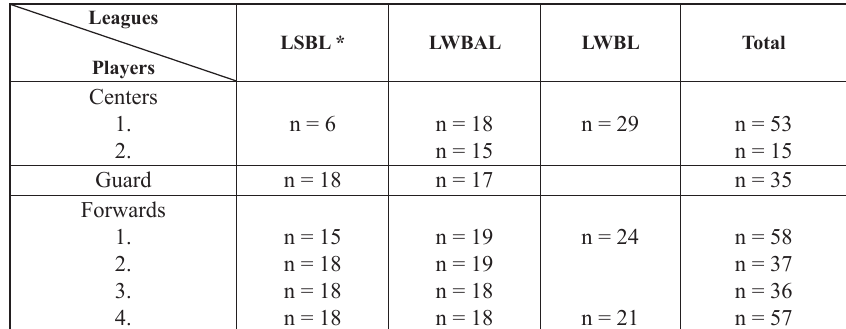
Note. LSBL – Lithuanian Students Basketball